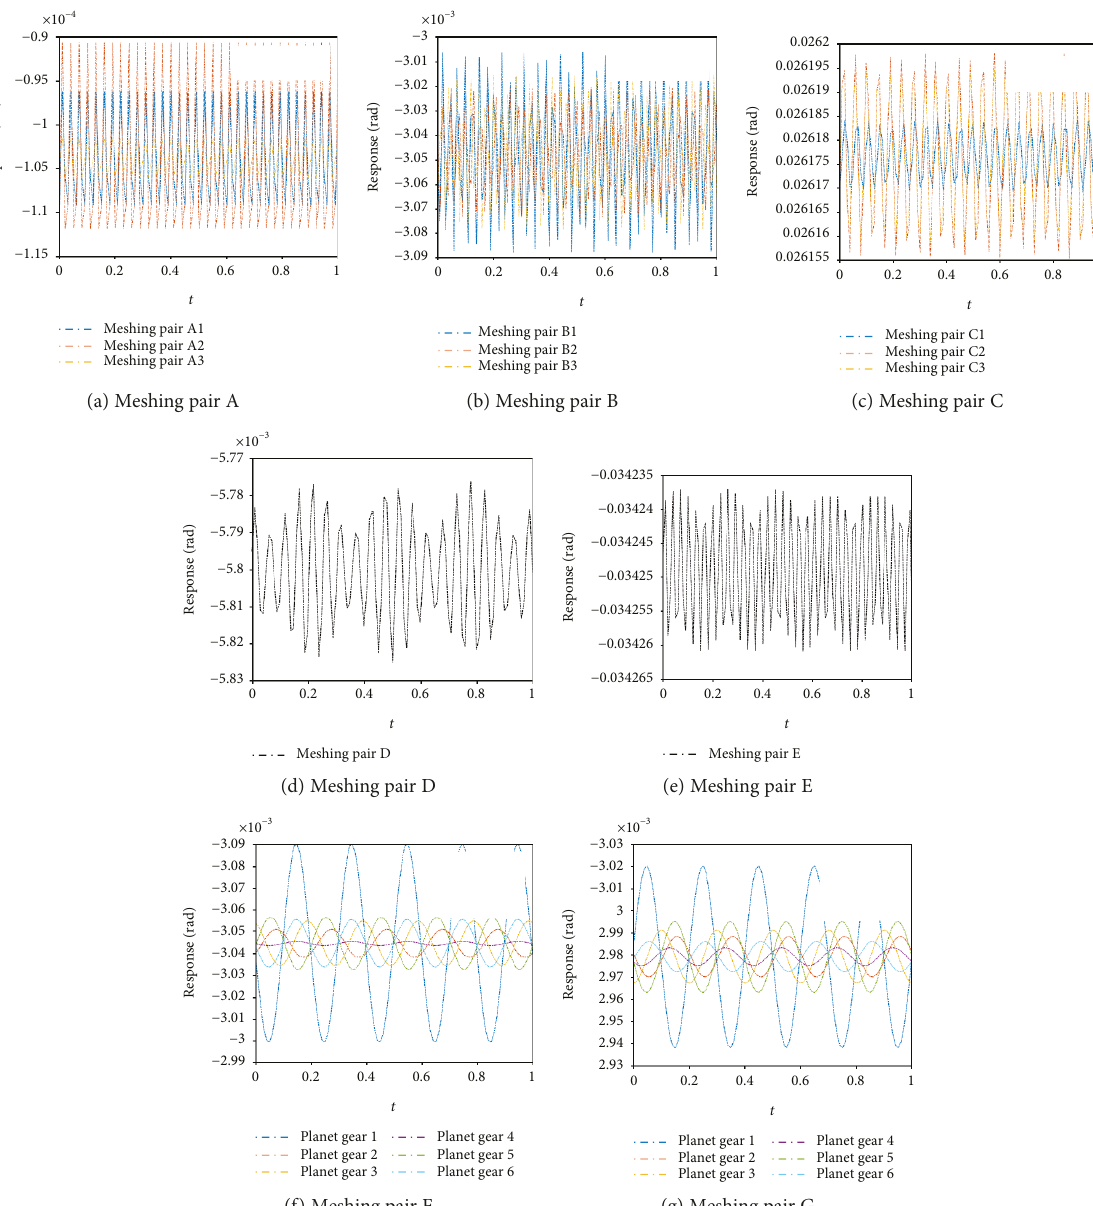
Figure 2: Dynamic response regarding tooth de fl ection in each gear